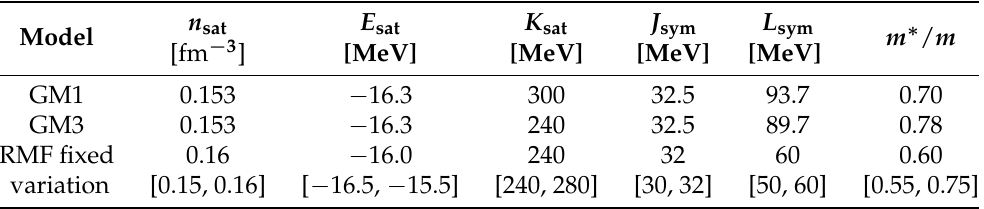
Table 1. Empirical parameter values for RMF models considered in this paper; see text for more